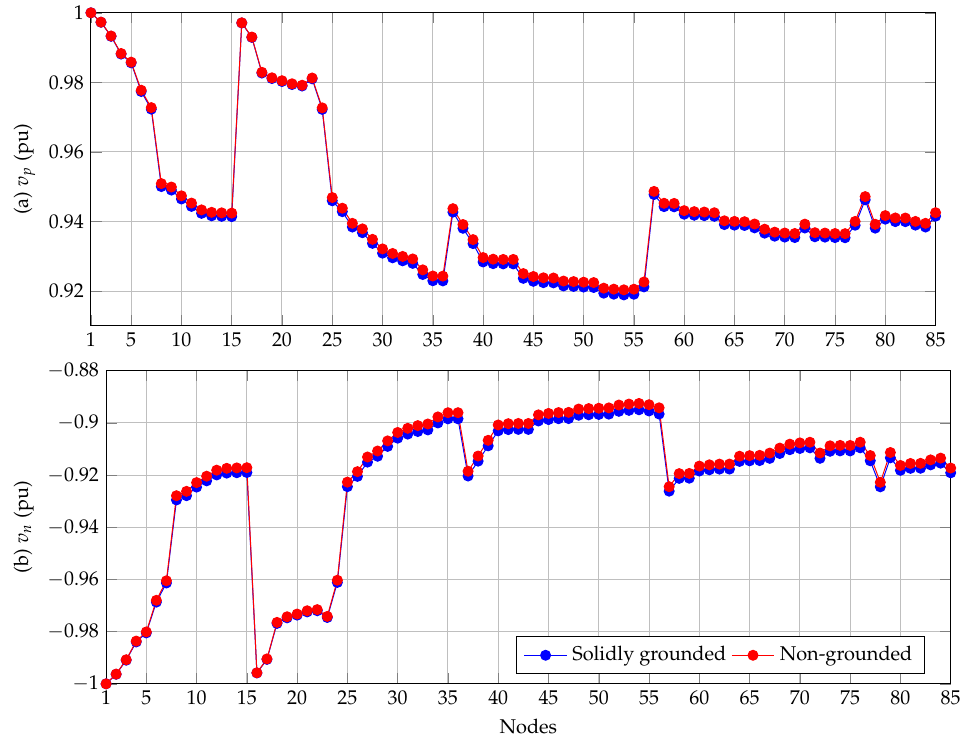
Figure 5. Voltage behavior for the 85-bus grid considering solidly-grounded and non-grounded neutral